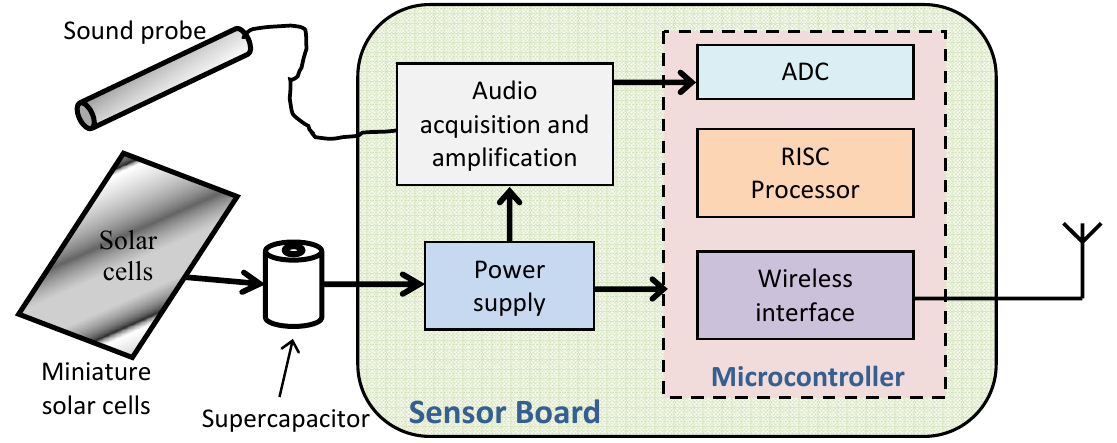
Figure 1. Block diagram of the proposed RPW bioacoustic